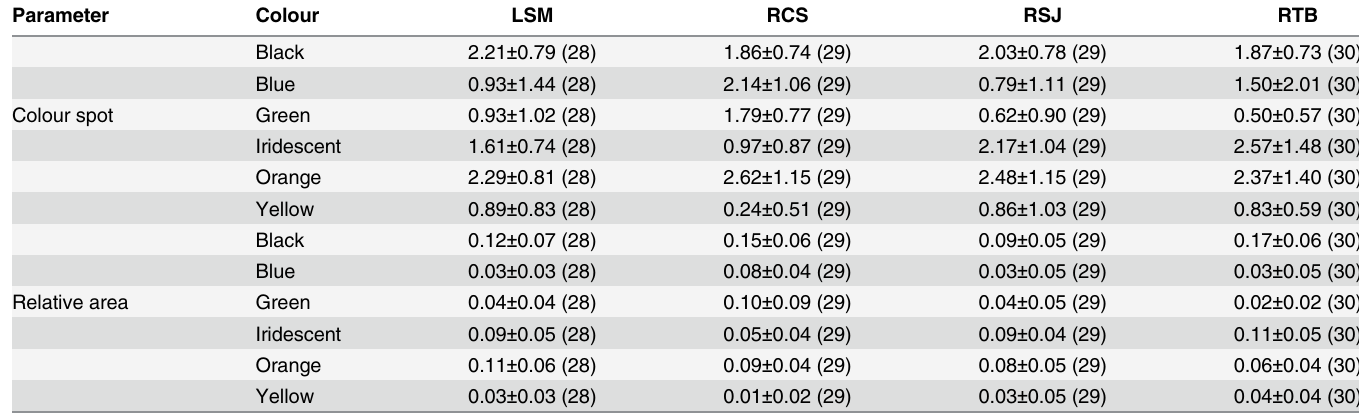
Table 4. Colour parameters in introduced populations of Poecilia reticulata in Panama. The data represent mean ± standard deviation (SD) and sam- ples sizes (N) estimated across sites: Lake Santa Mónica (LSM), Cristo Sacramentado (RCS), San Juan (RSJ) and Tres Brazos (RTB).